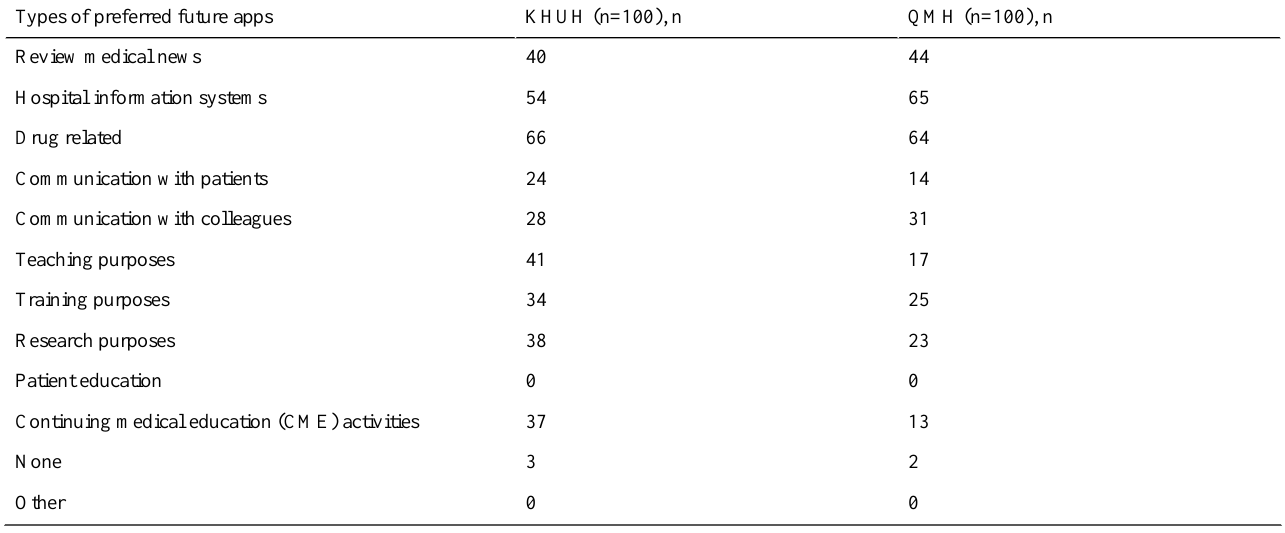
Table 5. Types of future apps preferred by doctors in King Hamad University Hospital (KHUH) and Queen Mary Hospital (QMH). Participants were asked to select up to 3